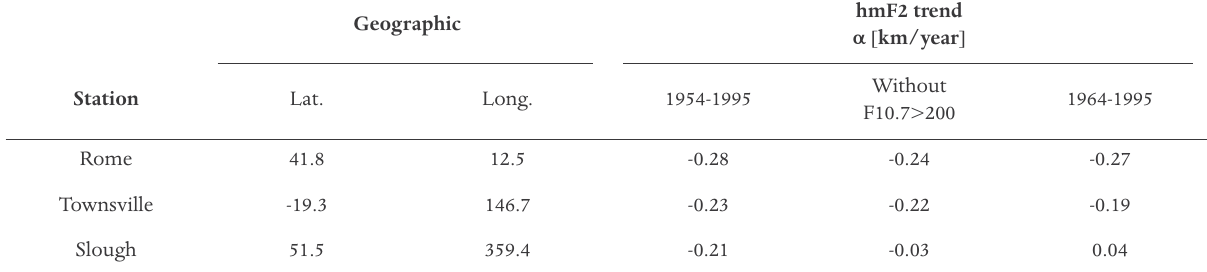
Table 2. Trend values: hmF2 residual trends for three ionospheric stations calculated for three periods: 1954-1995 that includes solar cycle 19, 1954-1995 excluding periods where F10.7 exceeded 200 and 1964-1995 that do not includes cycle 19. Residuals assessed using F10.7 as solar EUV proxy.